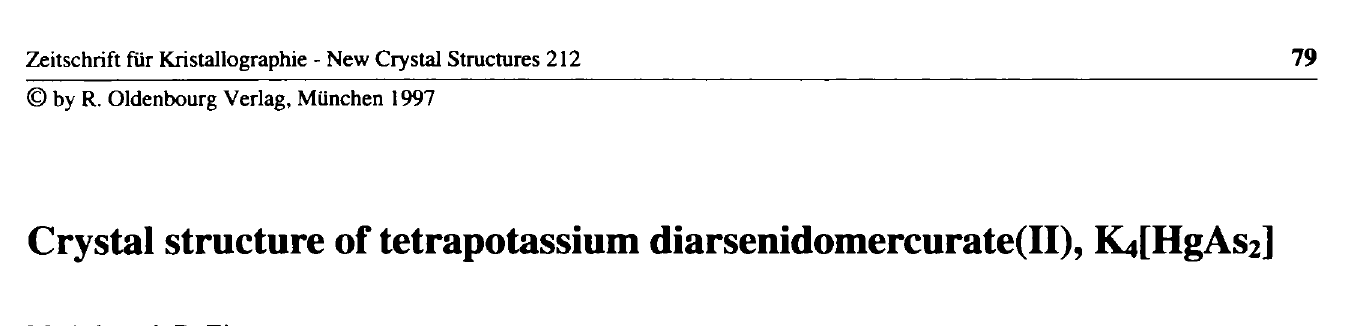
Source of material: K4[HgAs2] was synthesized from stoichiome- tric amounts of the elements in sealed niobium ampoules. The samples were heated to 950 Κ within 4 h and cooled to room temperature for 40 h. An excess of potassium (10-20 at%) was used to improve the crystallization and removed by vacuum distillation. 1) containing isolated linear [As—Hg-As] 4- anions which are isosteric to the HgCb molecule. The bond length </(Hg-As) = 2.463 À is in good agreement with the sum of covalent radii for single bonds (see refs. 2,3). The anion belongs to the isoelectronic series HgCh, [CuBn]", [HgOa] 2 " [AgOa] 3- , [HgP 2 ] 4_ , [CuSbif* (see refs. 4,5,6). Table 1. Parameters used for the X-ray data collection